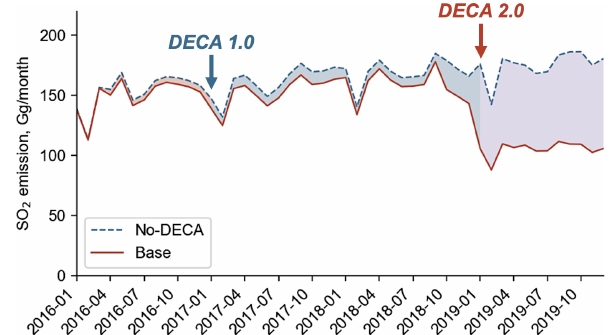
Figure 13. Monthly variation in ship SO 2 emissions in inland rivers and the 200Nm zone of China under the base condition and the No- DECA scenario in 2016–2019. The base condition refer to the real condition. The No-DECA scenario reflects the emissions based on the real ship activities without DECA policies.